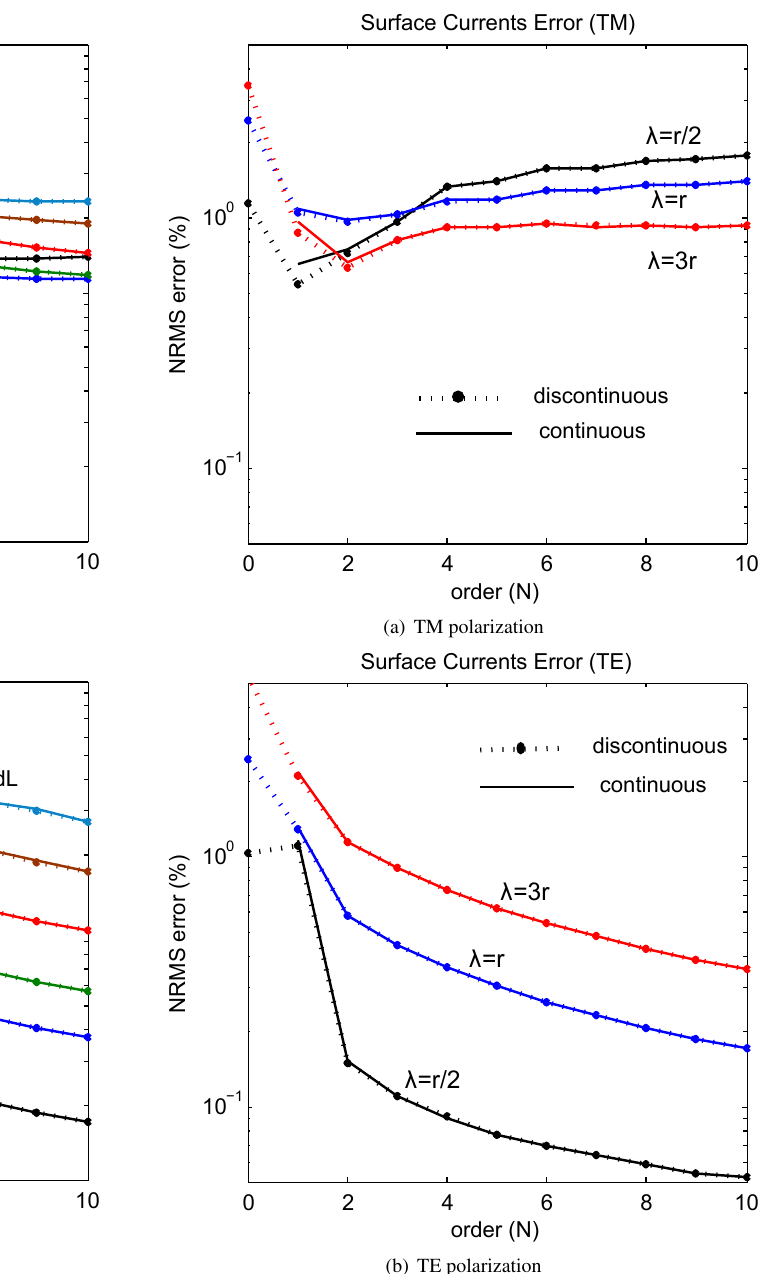
Figure 11: Log plot of surface current error versus the order and L for λ = r